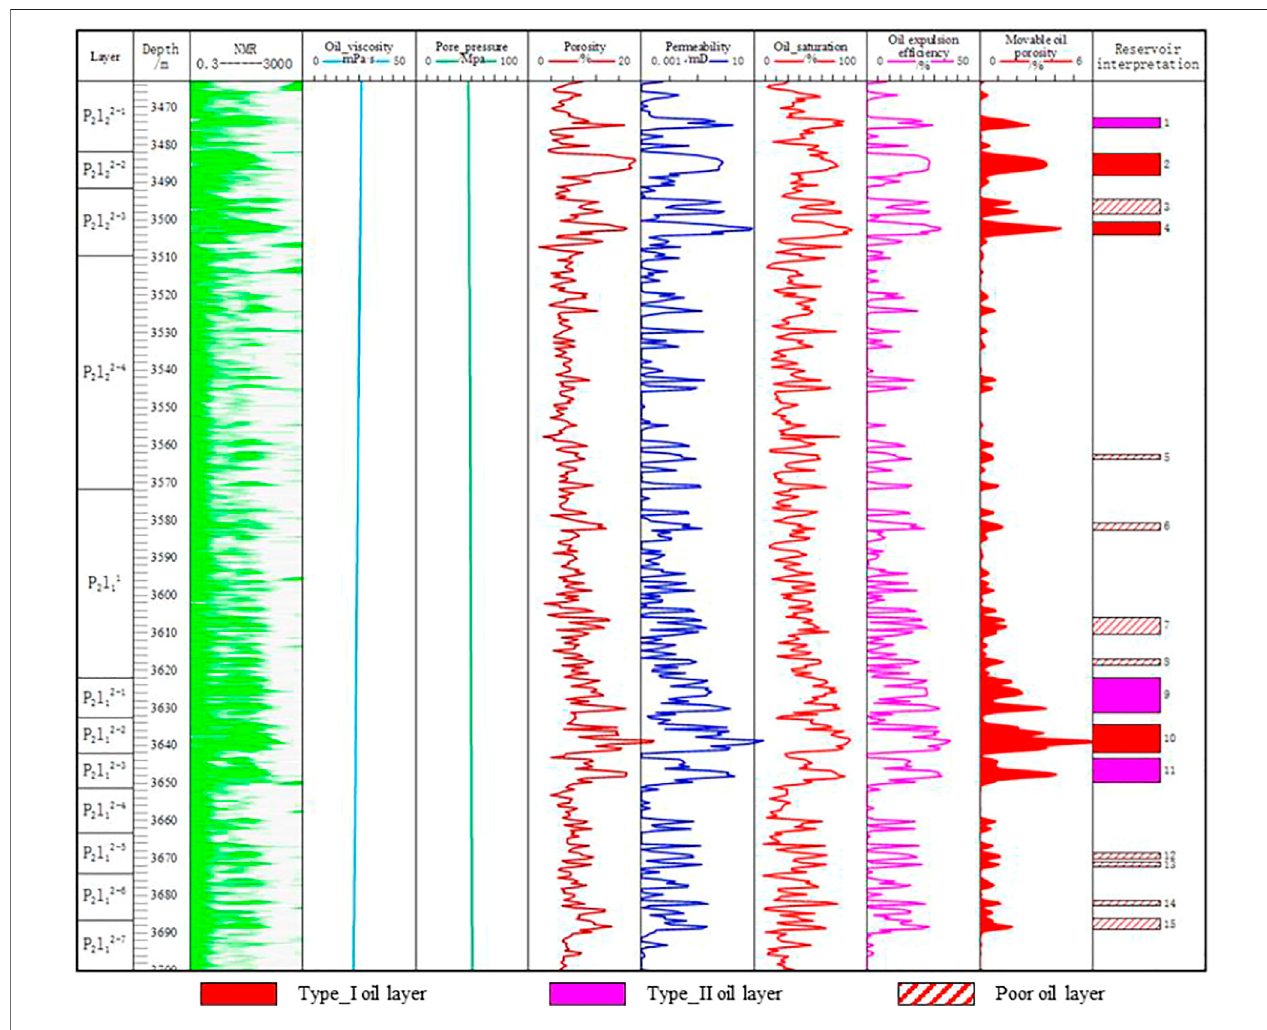
FIGURE 14 | Comprehensive interpretation of shale oil mobility in well J10024.